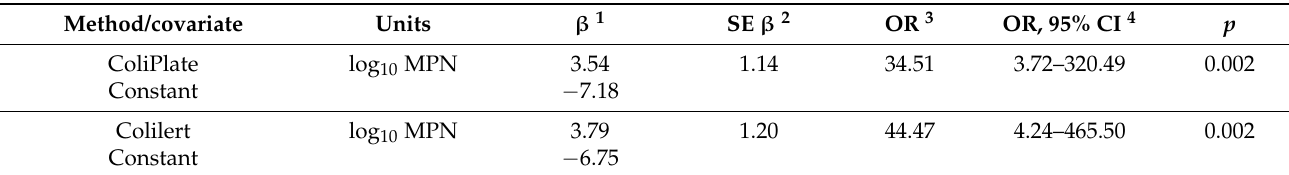
Table 2. Two simple logistic regression models showing the relationship between the E. coli density measurements obtained using ColiPlate and Colilert for predicting a very high-risk E. coli density (> 100 colony-forming units per 100 mL) in natural water samples using the membrane filtration method.